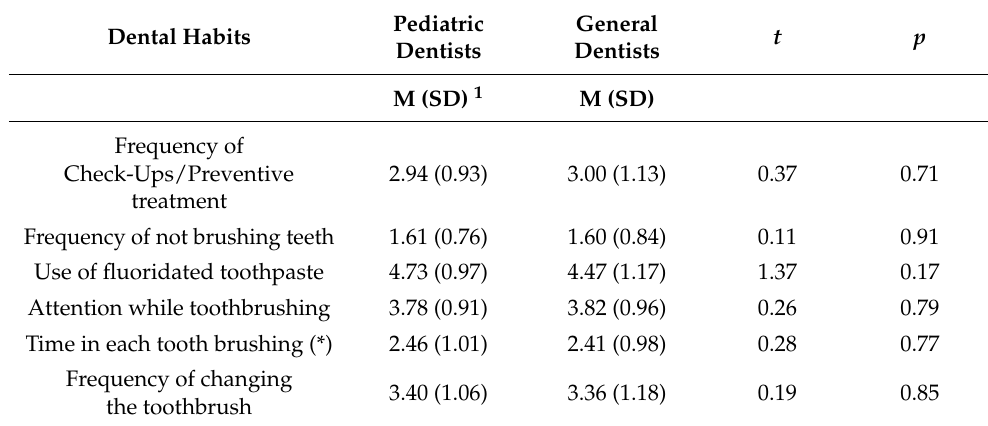
Table 4. Comparison of dental habits between paediatric and general dentists’